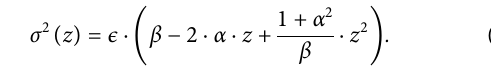
Frontiers in Physics |